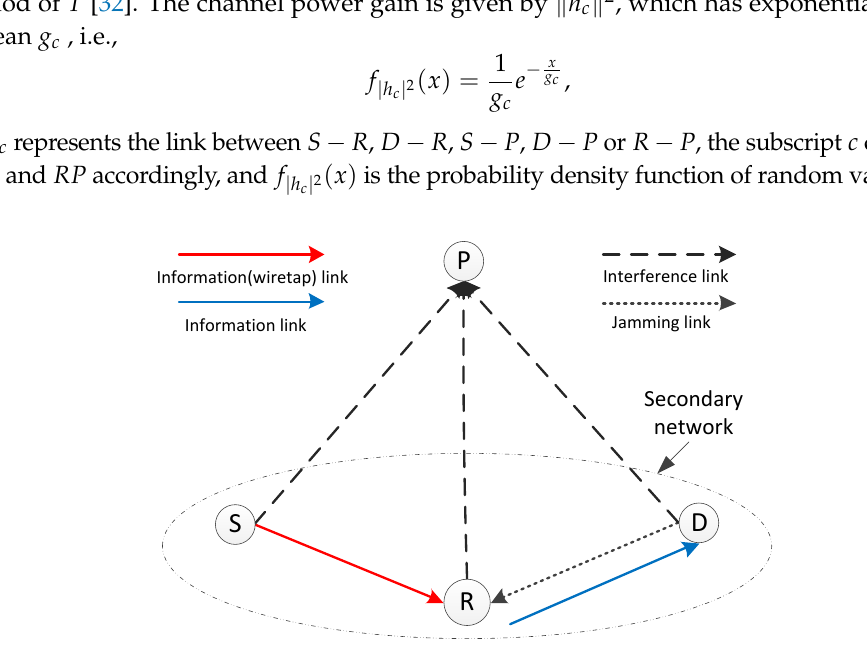
Figure 1. A brief system model of the CIoT